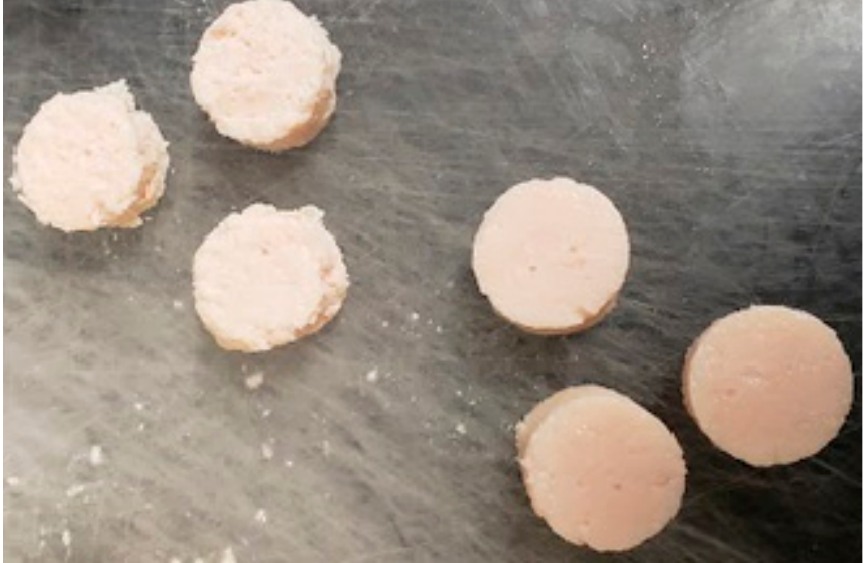
Figure 3. Sections of the cooked meat made with minced SM poultry breast meat ( left : SM, right : SM + caseinate).